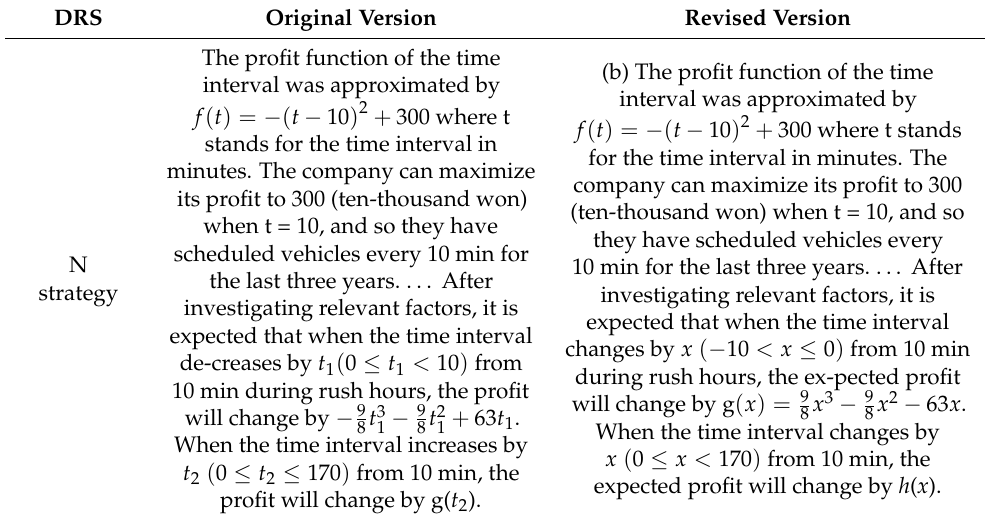
Table 3. N Strategy (Revising